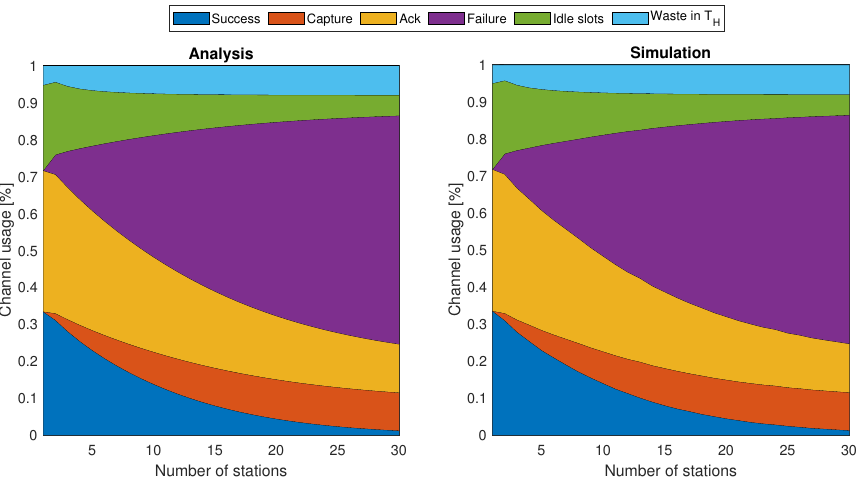
Figure 10. Channel usage ratio by different events occupying the RAW slot interval with capture threshold z = 8dB, in terms of contending